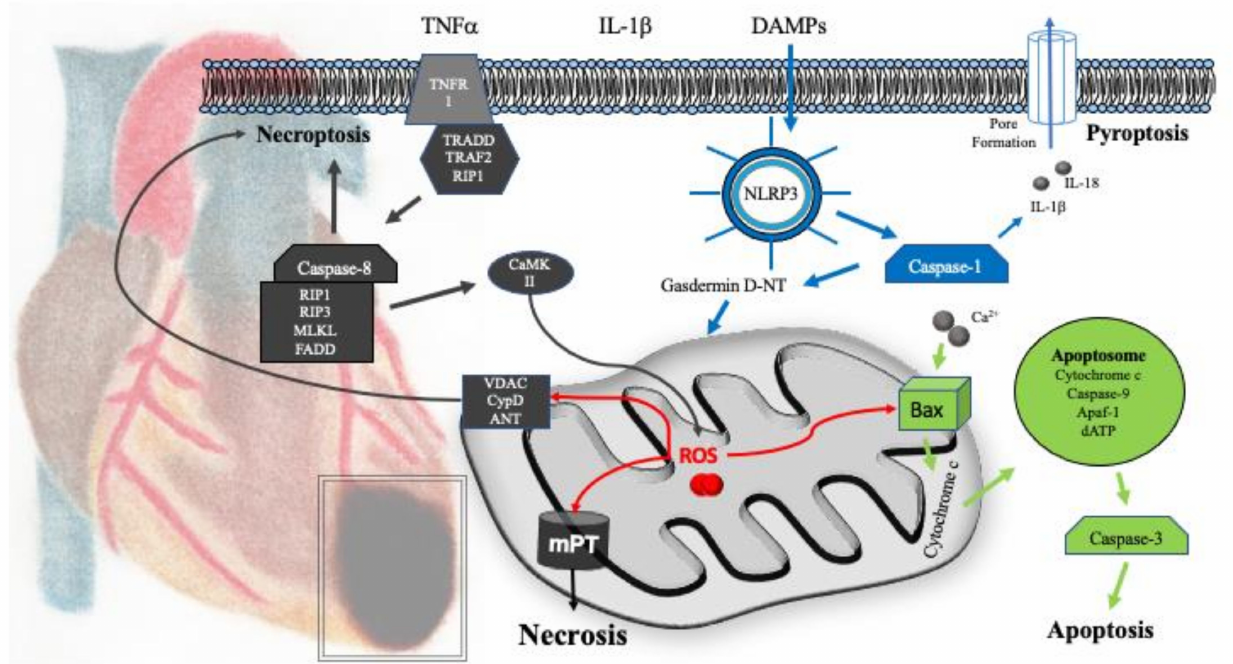
Figure 3. Mechanisms of cell death after myocardial I/R injury. After hypoxia, myocardial cell death is primarily driven by necrosis subsequent to the loss of mitochondrial function and opening of the mitochondrial permeability transition pore (mPTP). Necrosis also exists as a regulated form of cell death, i.e., necroptosis. Necroptosis is initiated via the activation of death receptors (e.g., tumor necrosis factor receptor 1 (TNFR1). Signaling commences via receptor-interacting protein 1 (RIP1), which mediates the activation of receptor-interacting protein 3 (RIP3) and mixed lineage kinase domain- like (MLKL) alternative activation of calcium-calmodulin-kinase II (CaMKII) by the RIP3/RIP1/MLKL/FADD complex induces mitochondrial dysfunction and membrane permeabilization via cyclophilin D, VDAC, and ANT. Pyroptosis is associated with inflammation subsequent to the ischemic insult and mediated via the NLRP3-inflammasome, caspase-1, and enhanced cytokine production. Mitochondria related apoptosis can also be elicited via mechanisms culminating in the release of cytochrome c and the formation of the apoptosome. Pharmacologic cardioprotection has been shown to act on all forms of cell death by maintaining mitochondrial function, reducing ROS production, as well as direct inhibition of apoptotic signaling or the activation of pro-survival signaling pathways, respectively. Abbreviations: ANT = adenine nucleotide translocator; Apaf-1 = apoptotic protease activating factor 1; Bax = Bcl-2-associated X protein; CaMKII = calcium- calmodulin-kinase II; DAMPs = damage-associated molecular patterns; FADD = Fas-associated protein with death domain; IL-1 β = interleukin-1 β ; IL-18 = interleukin-18; MLKL = mixed lineage kinase domain-like; NLRP3 = NOD-, LRR-, and pyrin domain-containing protein 3; RIP1 = receptor-interacting protein 1; TNF α = tumor necrosis factor α ; TNFR1 = tumor necrosis factor receptor 1; TRAF2 = tumor necrosis factor receptor-associated factor 2; TRADD = tumor necrosis factor receptor type 1-associated DEATH domain; VDAC = voltage-dependent anion-selective